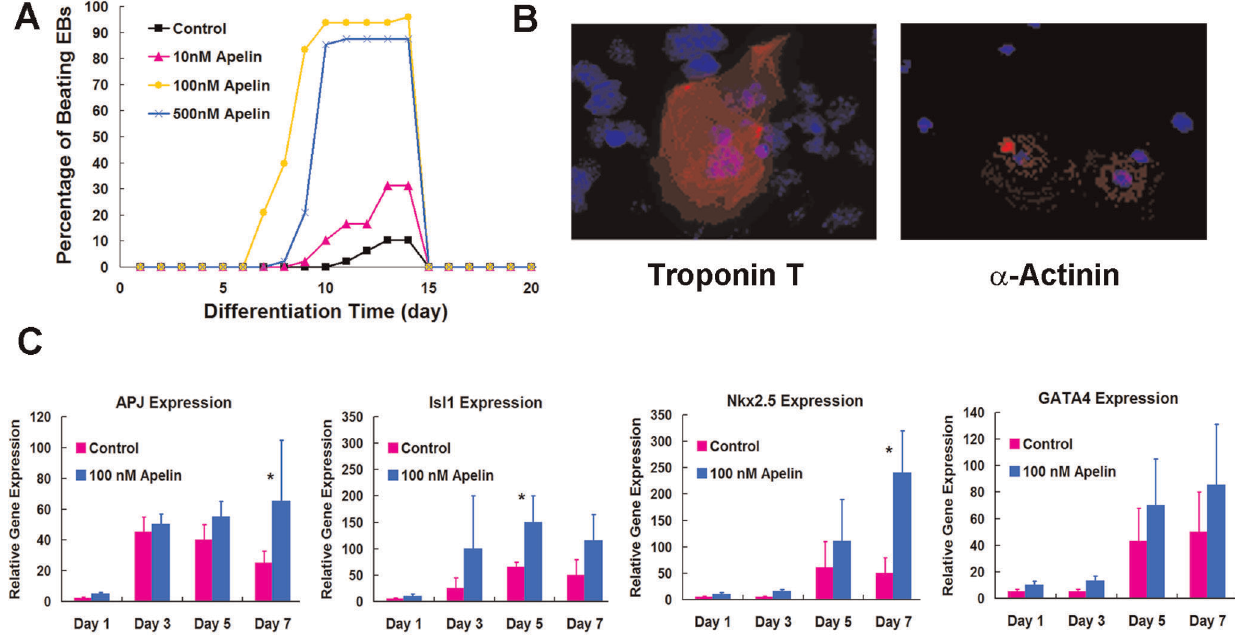
Figure 2. Effect of different concentrations of apelin on mEBs. (A) Percentage of beating EBs, (B) Immunohistochemistry of cardiac troponin T (cTNT, red) and a -actinin on day 14 (red, and blue stain: Hoechst nuclear stain), (C) Quantitative RT-PCR demonstrates significant increase of Isl1 on day 5 and of Nkx2.5 and APJ on day 7 (*p , 0.05), and a trend of increase in GATA4 expression.